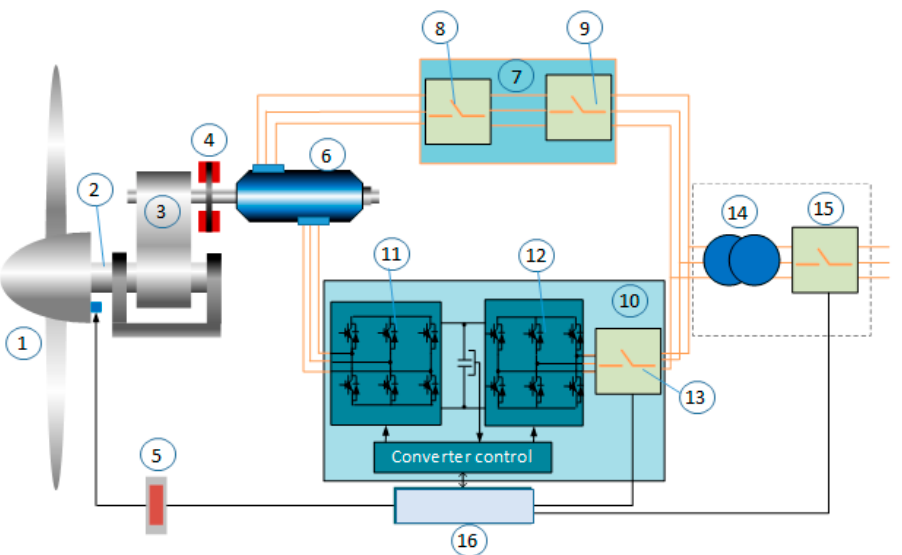
Figure 2. Schematic of wind turbine control system diagram. ( 1 ) Rotor; ( 2 ) main shaft; ( 3 ) gearbox; ( 4 ) brake system; ( 5 ) pitch control system; ( 6 ) generator; ( 7 ) power control to the grid; ( 8 ) low voltage switchgear; ( 9 ) low voltage switchgear; ( 10 ) converter system; ( 11 ) generator side converter; ( 12 ) grid side converter; ( 13 ) on/off switch control; ( 14 ) transformer; ( 15 ) high voltage switchgear; ( 16 ) wind turbine controller.